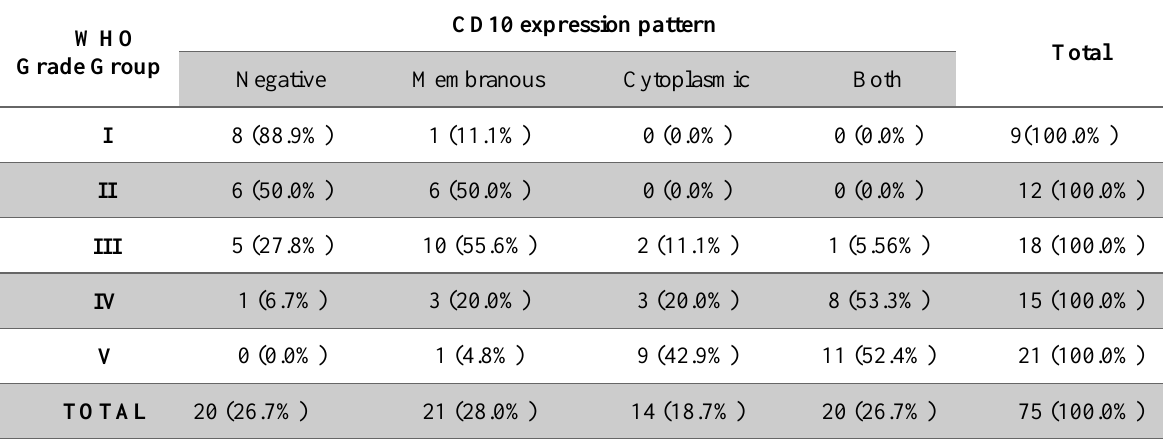
Table 3. Correlation between WHO Grade Group and pattern of CD10 expression